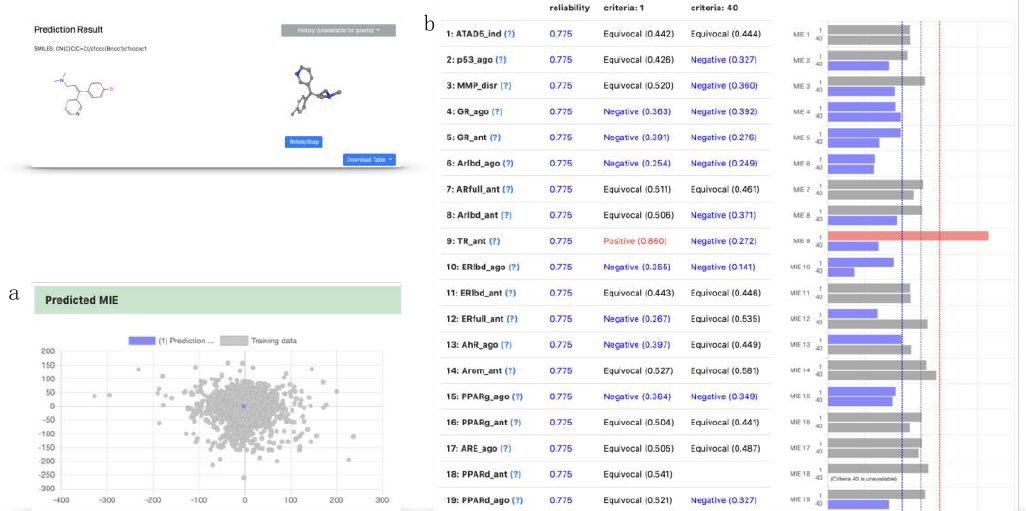
Figure 6. Prediction results in Toxicity Predictor: ( a ) the position of the compound to be predicted in the training set chemical space visualized with principal component analysis. The gray points are compounds in the training set, and the blue point is the compound to be predicted. ( b ) The predictive results for 59 MIEs predicted by Toxicity Predictor for each of the criteria 1 and 40. Normalized prediction scores for each target were displayed as bar charts. Red, blue, and gray bars show scores above 0.6, below 0.4, and between 0.4 and 0.6, respectively.